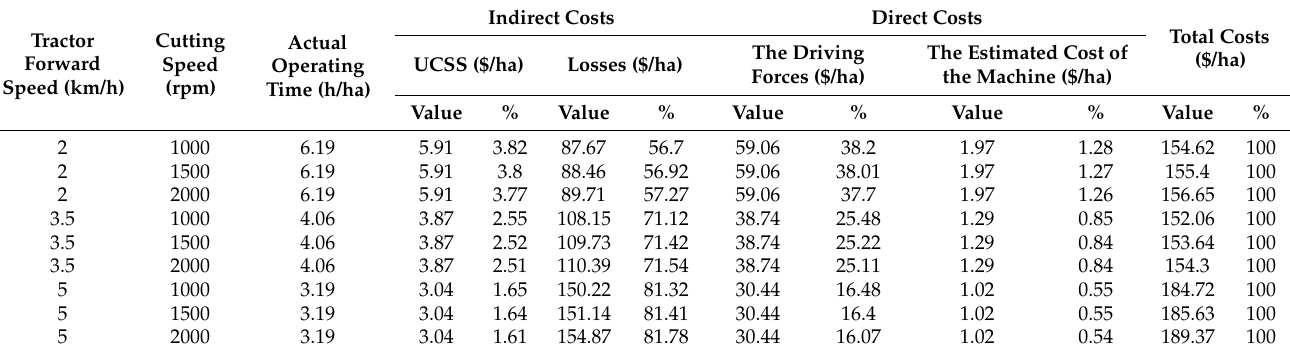
Table 2. The relative importance of the cost items for different forward and cutting speeds.